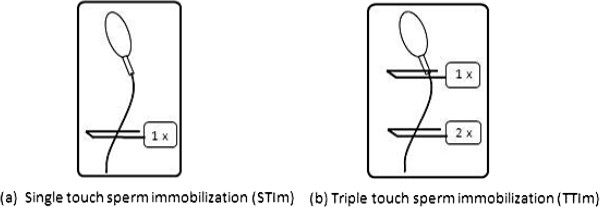
Sperm immobilization. (a) Standard procedure STIm : pressing the tip of the tail against the lid of the dish with a microinjection pipette until a clear small bend in the middle of the flagellum is visible (b) More aggressive procedure TTIm: based on application of the standard procedure twice and compression of the sperm mid-piece once.